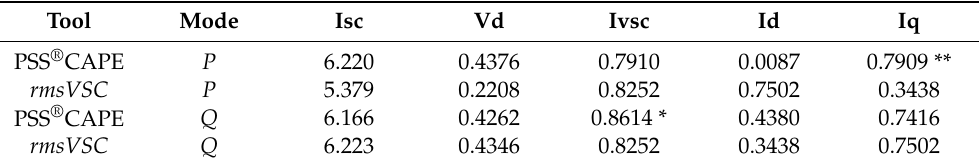
Table 3. Results for case 2 (60 MW/40 MVAr), for a fault at bus 3, under active or reactive current